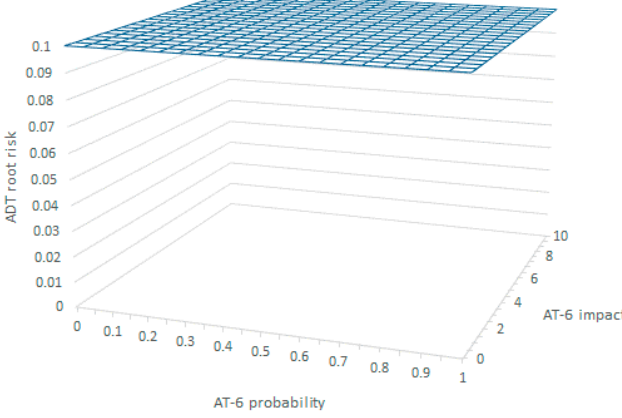
Figure 8. Risk sensitivity of the At6 attack event probability and impact.